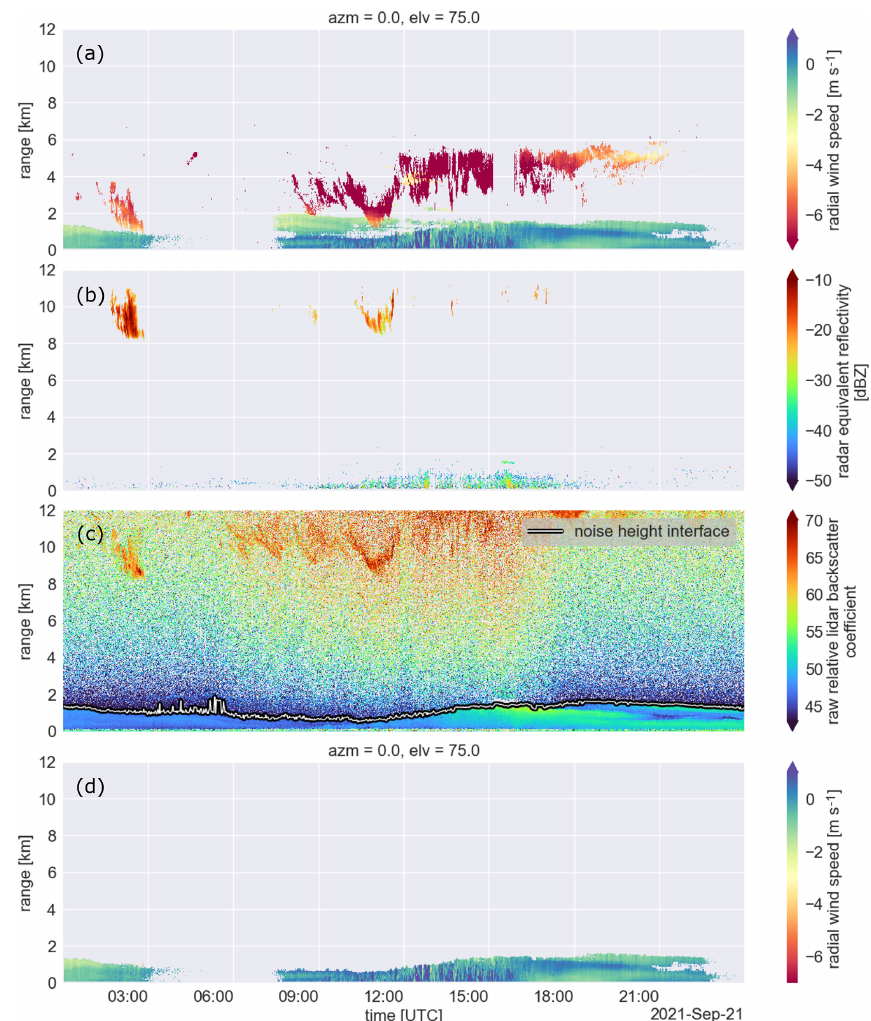
Figure 4. Time–height plots: (a) mean Doppler velocity measured by the WindCube, (b) radar equivalent reflectivity measured by MARA, (c) backscattered signal measured by a nearby Ceilometer, (note that the negative values are already set as NaN (not a number)), and (d) the same as in (a) , but after filtering for second trip echoes. The white shaded curve on (c) indicates the retrieved noise height interface.